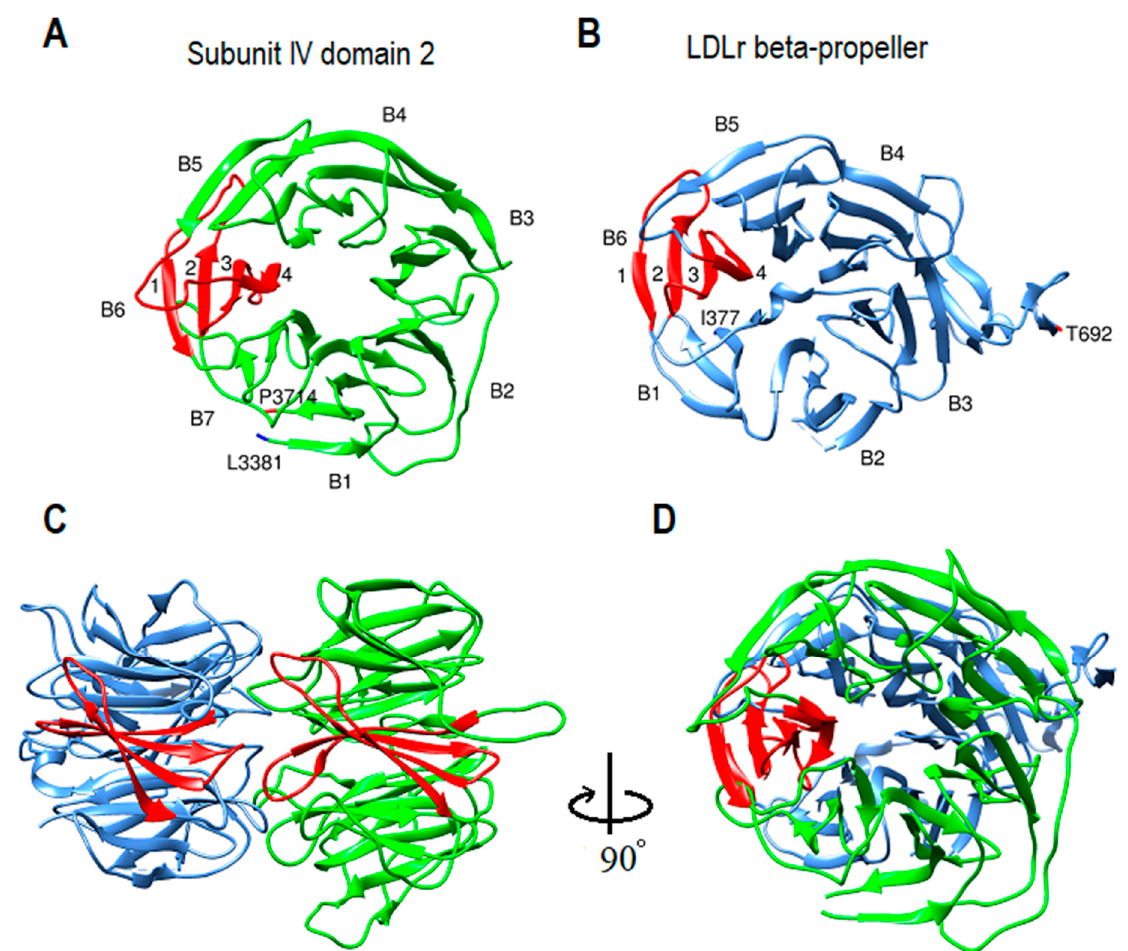
Figure 9. ApoB-100 subunit IV domain 2 comparison with low-density lipoprotein receptor (LDLr) β -propeller domain. ( A ) Ribbon representation of the computational model of the toroidal shape subunit IV domain 2 β -propeller begins at L3381 through P3714. This domain comprises seven blades (B1–B7), and each blade is made from four β -strands. ( B ) Ribbon representation of the crystal structure of the LDLr β -propeller domain begins at I377 through T692 and consists of six blades (B1–B6) [60]. ( C , D ) The side and top aspects of the apoB-100 domain and LDLr domain show that both domains have a similar structure and are complimentary.